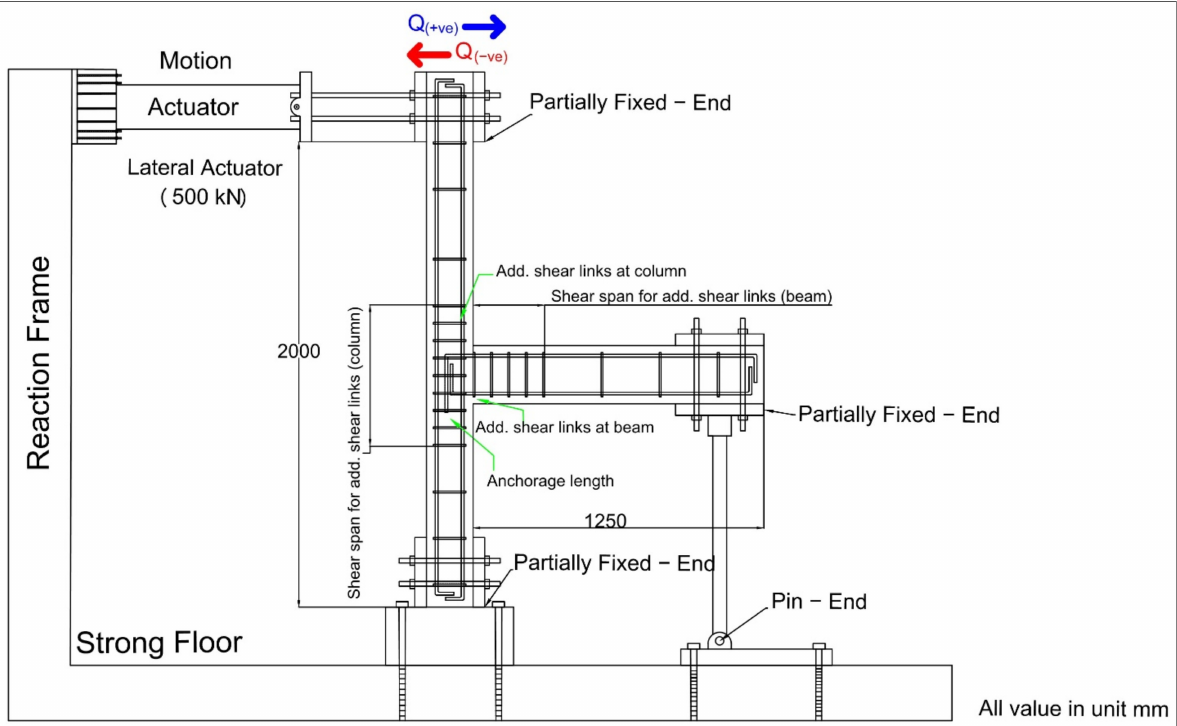
Figure 2. Typical setup of RC beam-column joint